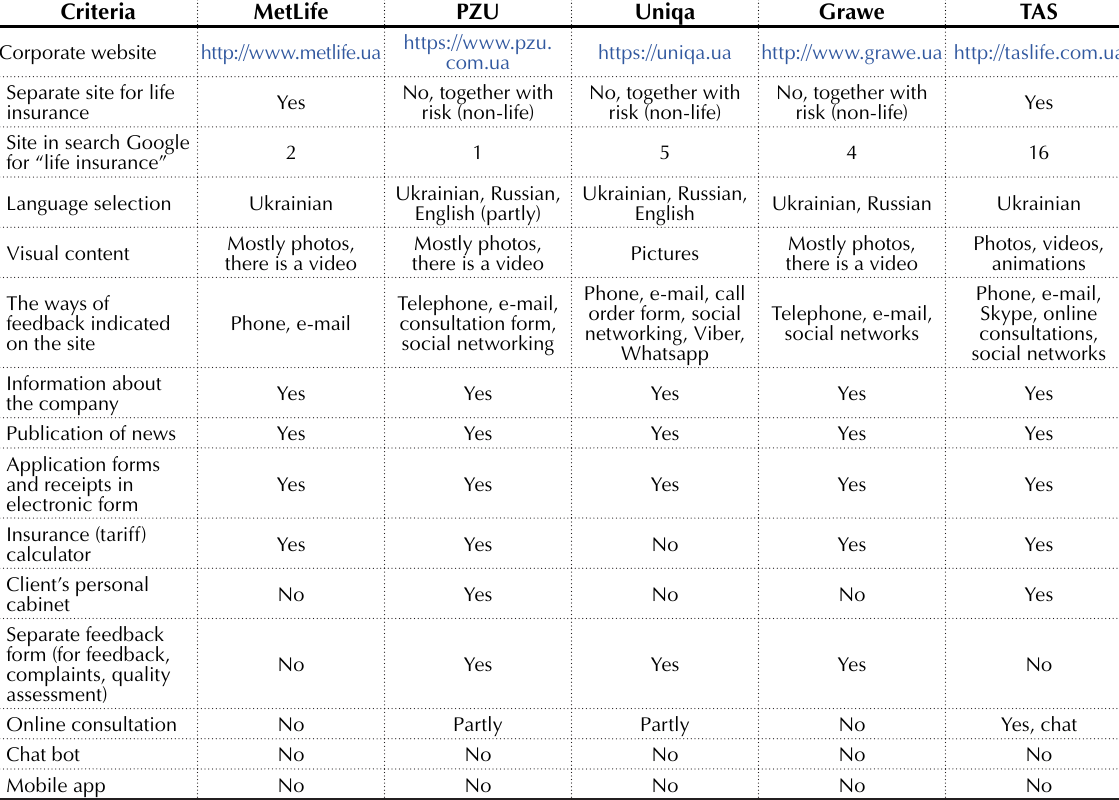
Table 3. Comparison of corporate life insurance company websites